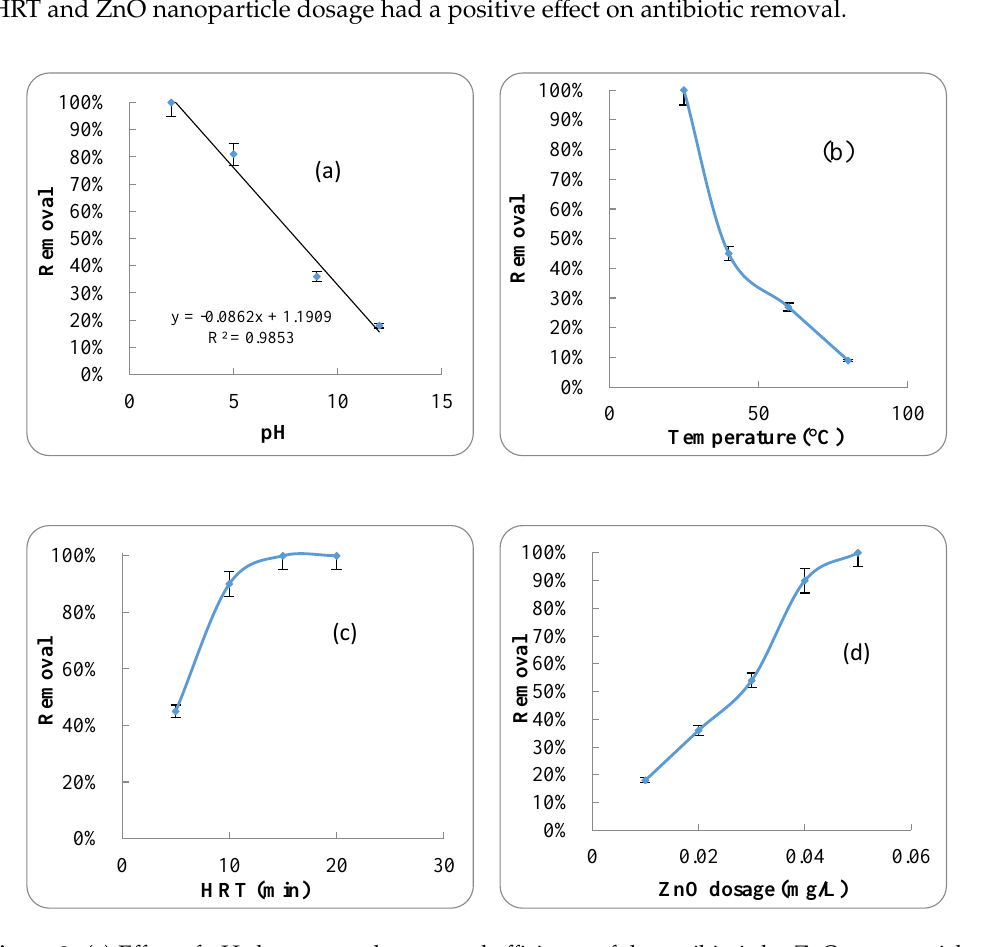
Figure 3. ( a ) E ff ect of pH changes on the removal e ffi ciency of the antibiotic by ZnO nanoparticles; Figure 3. ( a ) Effect of pH changes on the removal efficiency of the antibiotic by ZnO nanoparticles; ( b ) the effects of different temperatures on antibiotic adsorption by ZnO nanoparticles; ( c ) the effect ( b ) the e ff ects of di ff erent temperatures on antibiotic adsorption by ZnO nanoparticles; ( c ) the e ff ect of of HRT changes on the antibiotic removal efficiency by ZnO nanoparticles and ( d ) the effect of HRT changes on the antibiotic removal e ffi ciency by ZnO nanoparticles and ( d ) the e ff ect of di ff erent different concentrations of ZnO nanoparticles on antibiotic removal efficiency. concentrations of ZnO nanoparticles on antibiotic removal e ffi